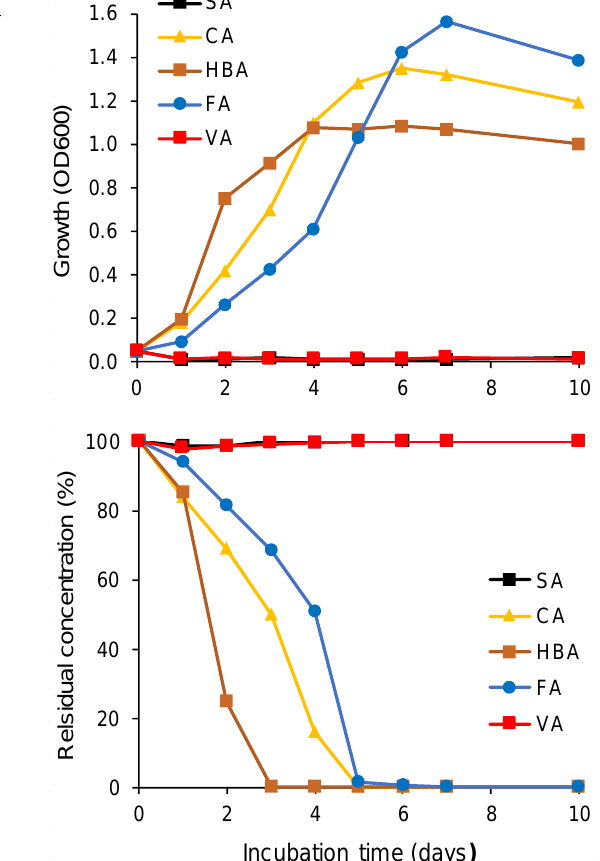
Figure 2. Utilization as the sole carbon source (( A ): growth; and ( B ): degradation) of lignin-derived aromatic monomers (SA, syringic acid; CA, p -coumaric acid; HBA, 4-hydroxybenzoic acid; FA, trans -ferulic acid; VA, vanillic acid; 100% = 5 mM) by R. colostri DBVPG 10655 at 10 °C (mean values of three replicates; SDs ≤ 10%).